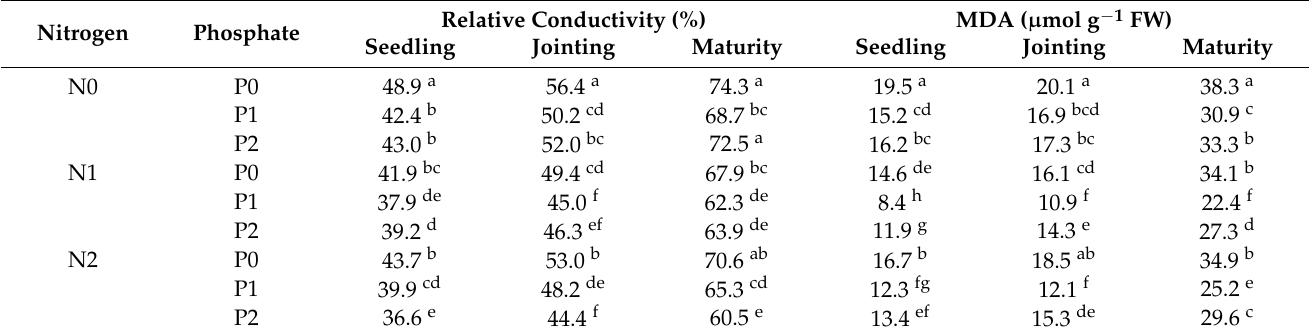
Table 3. Effects of nitrogen and phosphorus on relative conductivity and malonaldehyde (MDA) content of sorghum plants grown in saline soils at the three growing stages of seedling, jointing, and maturity.